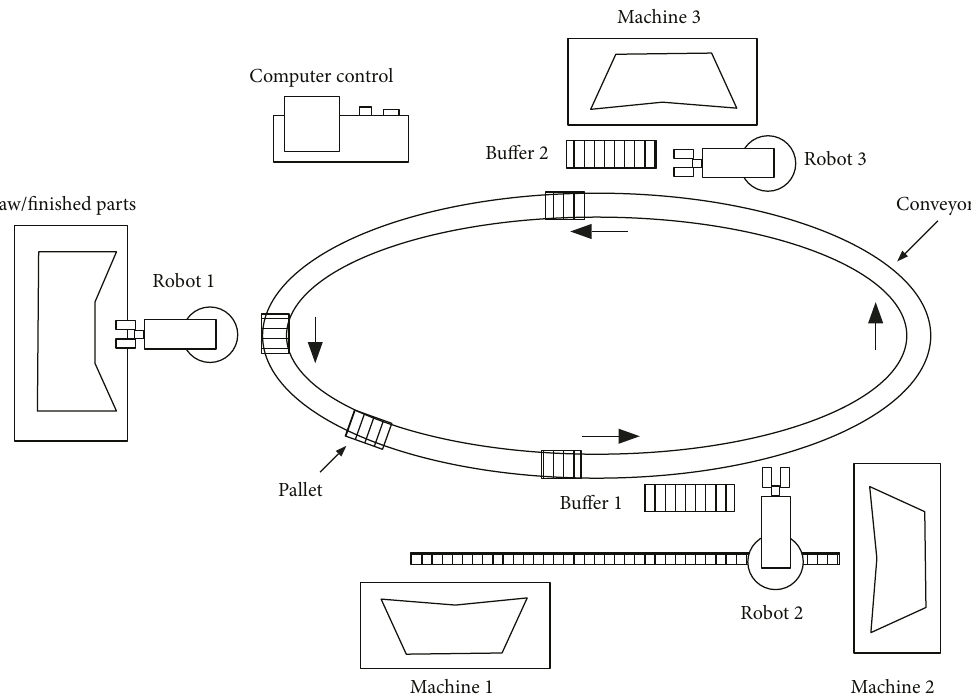
Figure 1: An automated manufacturing system (the arrows in bold shows the movement of the